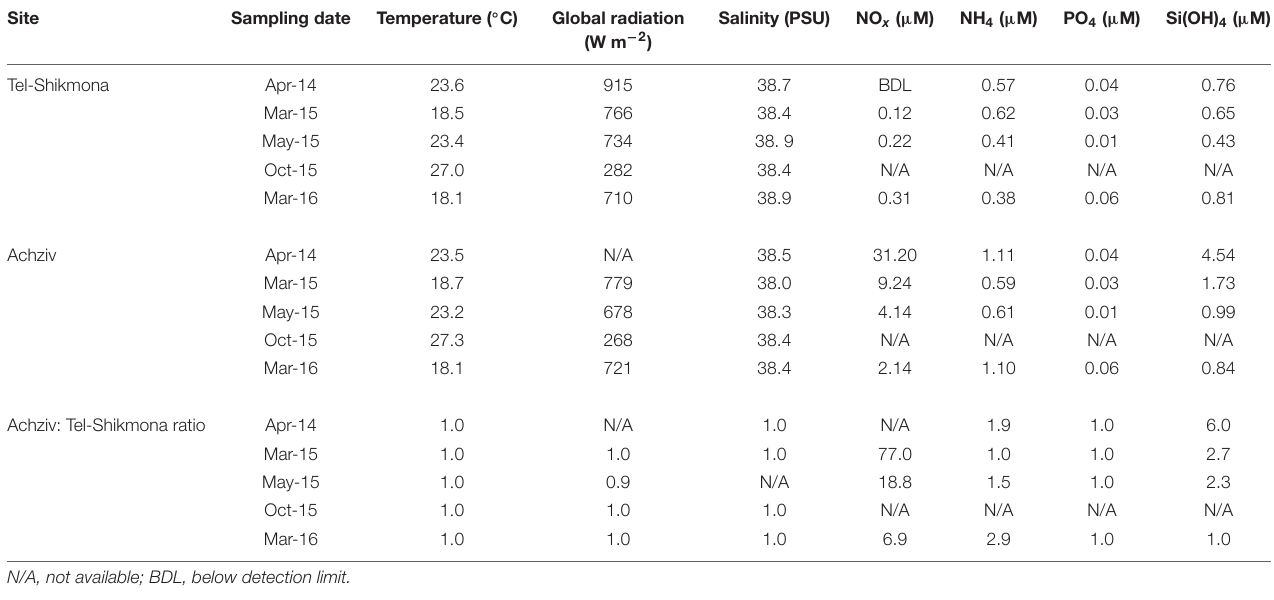
TABLE 1 | Temperature, radiation, and salinity levels in surface waters ( ∼ 0.5 m) of Achziv and Tel-Shikmona during the phytoplankton collection campaigns, and the calculated ratio between variables.